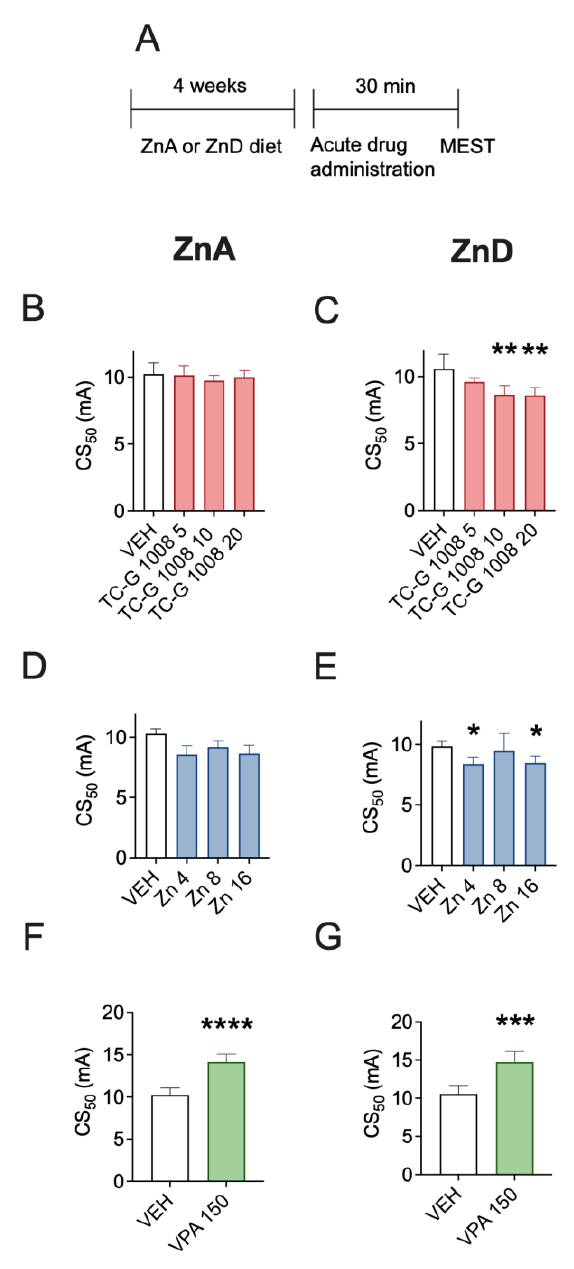
Figure 1. Acute effects of TC-G 1008, zinc chloride (ZnCl 2 ), or valproic acid (VPA) on the seizure threshold in the maximal electroshock seizure threshold (MEST) test in mice fed a zinc-adequate diet (ZnA) or a zinc-deficient diet (ZnD) ( A ) Experimental paradigm. Mice were fed the ZnA (50 mg Zn/kg) or the ZnD diet (3 mg Zn/kg) for 4 weeks. Following a 4-week dietary zinc restriction, drugs were administered acutely i.p. The doses of drugs are shown on abscissas in mg/kg. Control mice received vehicle (VEH) (1% Tween 80 in 0.9% NaCl) i.p. 30 min later the MEST test was performed. ( B – G ) The results are presented as CS 50 (in mA) values with upper 95% confidence limits. Data were analyzed by one- way ANOVA and the Dunnett’s multiple comparison test or the Student’s t -test. A total of 20 mice per group were used to determine the seizure threshold. Statistical details: ( B ) F(3,35) = 0.5781, p = 0.6333, ( C ) F(3,35) = 6.014, p = 0.002, ( D ) F(3,32) = 0.5369, p = 0.6604, ( E ) F(3,34) = 5.212, p = 0.0045 (B-E, one-way ANOVA), ( F ) t(17) = 6.631, p < 0.0001, ( G ) t(18) = 4.953, p = 0.0001 (F- G, Student’s t -test). * p < 0.05, ** p < 0.01, *** p < 0.001, **** p < 0.0001 vs. VEH group (Dunnett’s multiple comparison test or the Student’s t -test).